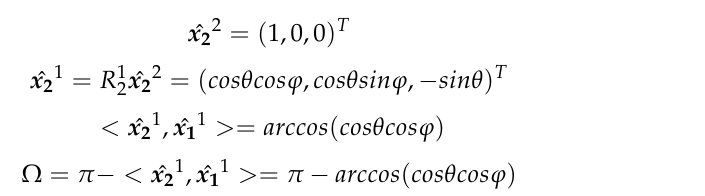
Figure 6. Elbow conversion from 2 DOF to 1 DOF. x 1 y 1 z 1 and x 2 y 2 z 2 are the DH coordinate systems connecting the two links of the elbow joint, respectively. Ω is the bending angle of the elbow